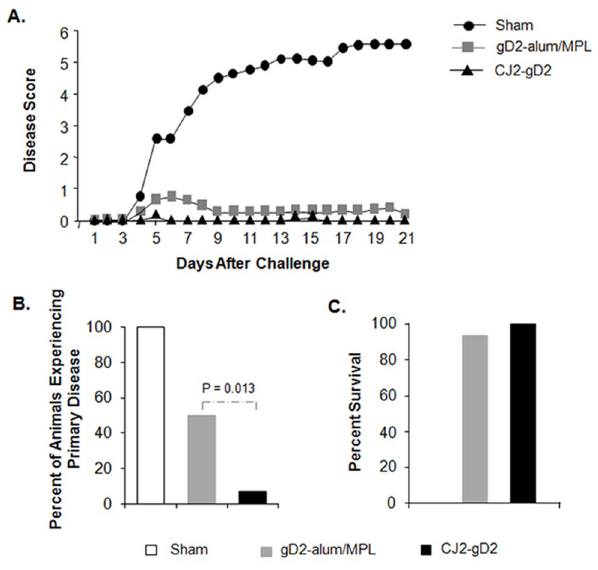
Figure 4. Prevention of primary HSV-2 genital disease in guinea pigs immunized with CJ2-gD2. Sham-immunized, gD2- alum/MPL- or CJ2-gD2-immunized guinea pigs described in Fig. 3 were monitored daily during a 60-day follow-up period for the incidence of genital and disseminated HSV-2 disease. The severity of disease was scored: 0, no sign of disease; 1, redness or swelling; 2, a few small vesicles; 3, several large vesicles; 4, several large ulcers with maceration; 5, paralysis; and 6, death. Presented are the disease scores for the first 21 days after challenge (A), the percent of animals that experienced primary herpetic disease (B), and the percent of survival until day 60 after challenge (C).